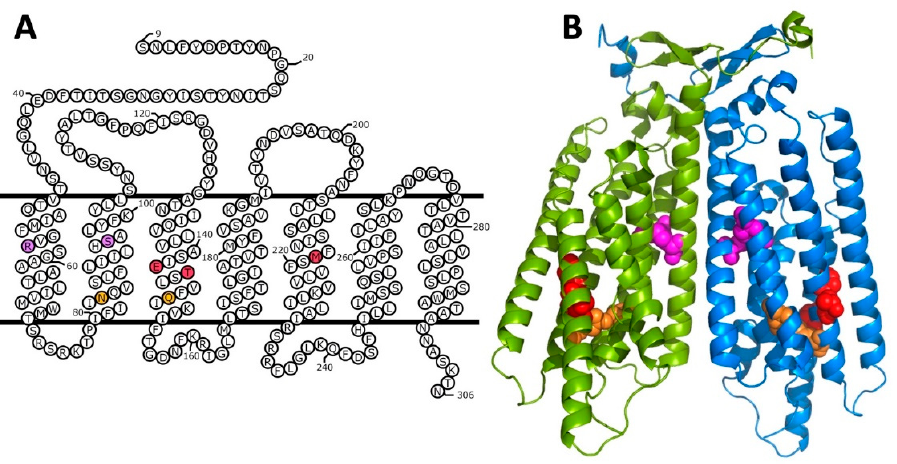
Figure 4. ( A ) Locations of mutation/suppressor pairs in relation to the transmembrane topology of Ste2p. Colored fills indicate different mutation/suppressor pairs. Red; loss of function mutations E143K and T144p are suppressed by M218T [54]. Orange; the Q149N mutation suppresses the constitutive activity of N84Q [56]. Magenta; various mutations at R58 suppress temperature sensitivity of S95Y [34]. ( B ) Locations of mutation/suppressor pairs in the cryo-EM structure of the ligand-free Ste2p dimer [37]. Colors of mutant/suppressor pairs are as shown in (panel A ). Ste2p monomers are shown in blue and green.